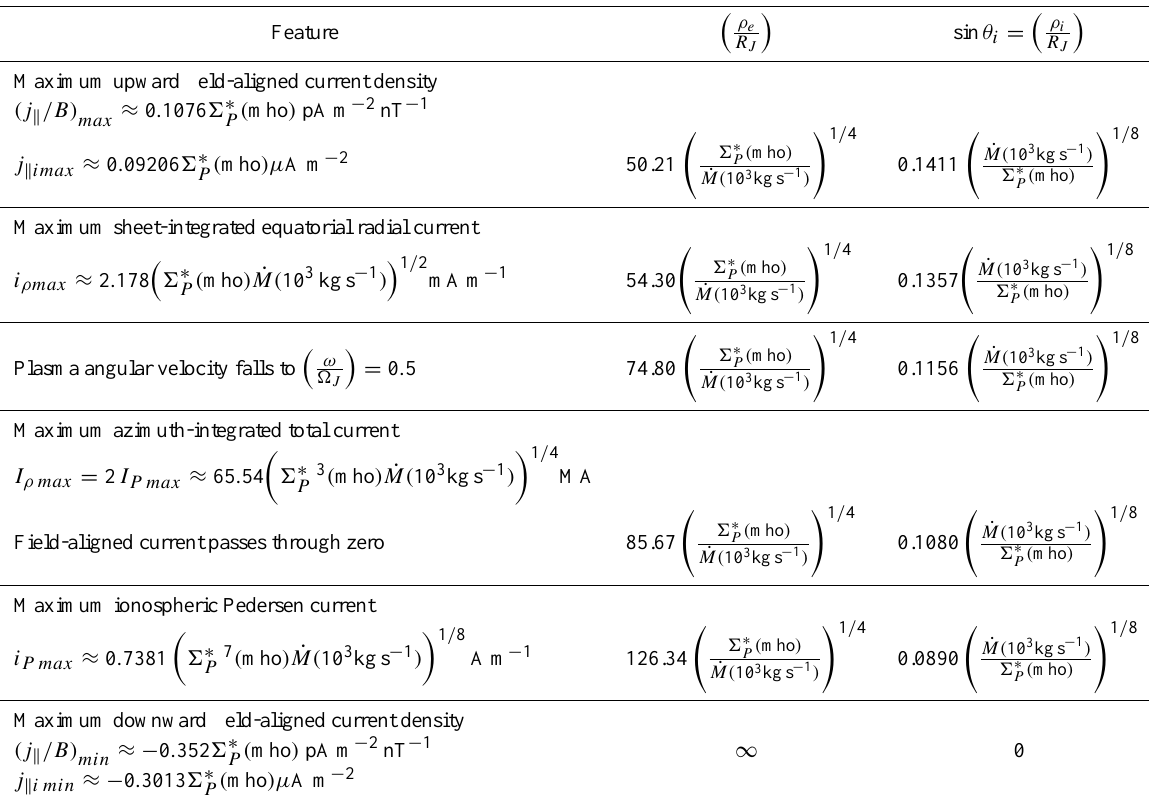
(cid:16) ρ (cid:17) e R J